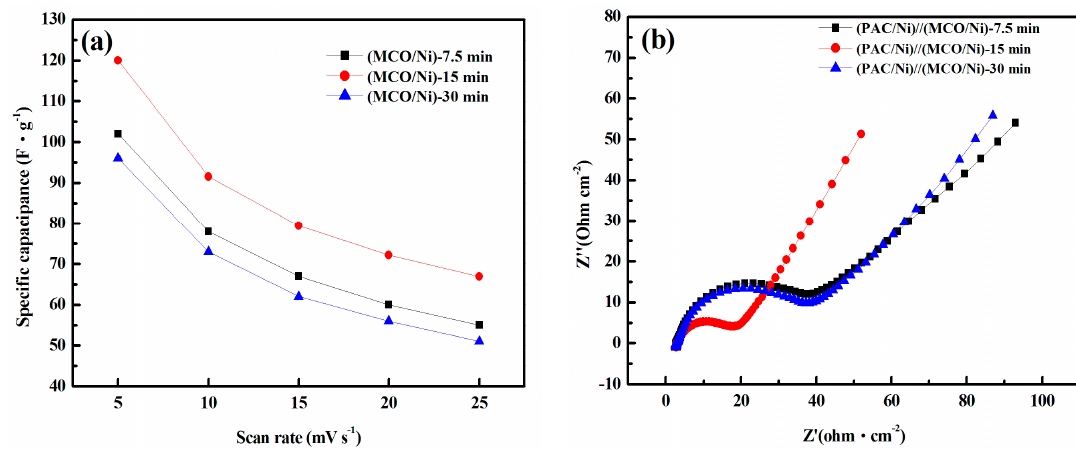
Figure 4. Cyclic voltammograms of ( a ) Plots of specific capacitance vs. potential scan rate of (MCO/Ni)-7.5 min, (MCO/Ni)-15 min, and (MCO/Ni)-30 min electrodes and ( b ) Nyquist plots of (PAC/Ni)//(MCO/Ni)-7.5 min, (PAC/Ni)//(MCO/Ni)-15 min, and (PAC/Ni)//(MCO/Ni)-30 min devices. (PAC/Ni)//(MCO/Ni)-7.5min, (PAC/Ni)//(MCO/Ni)-15min,